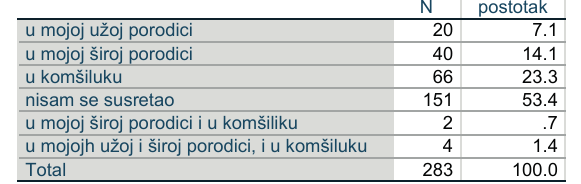
Tabela br. 3: Rezultati odgovora na pitanje Da li ste tokom svog perioda odrastanja (do 18 god) susretali sa porodičnim nasiljem u neposrednoj okolini?